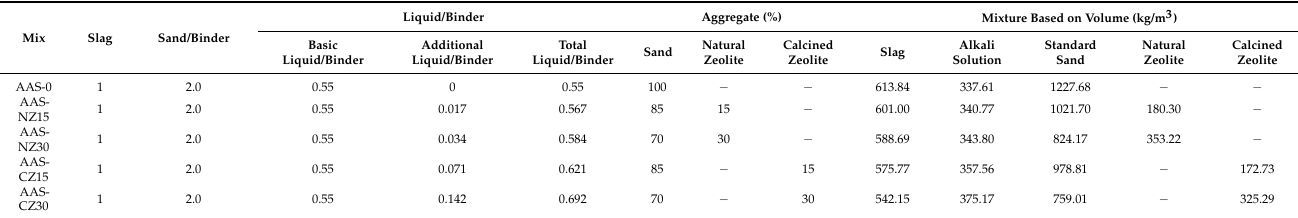
Table 2. Mix proportions based on mass and